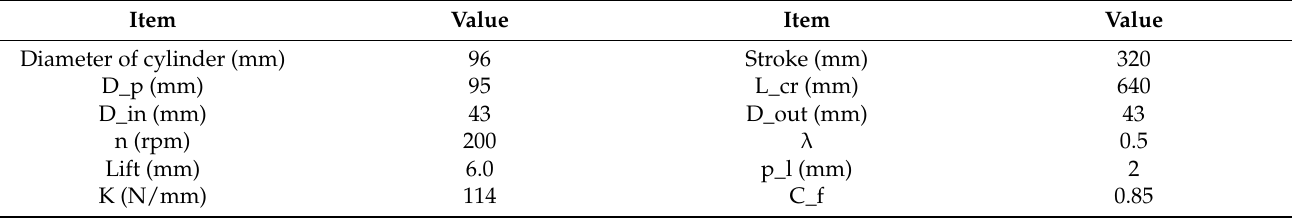
Table 1. Dimensions of the cylinder and valve.